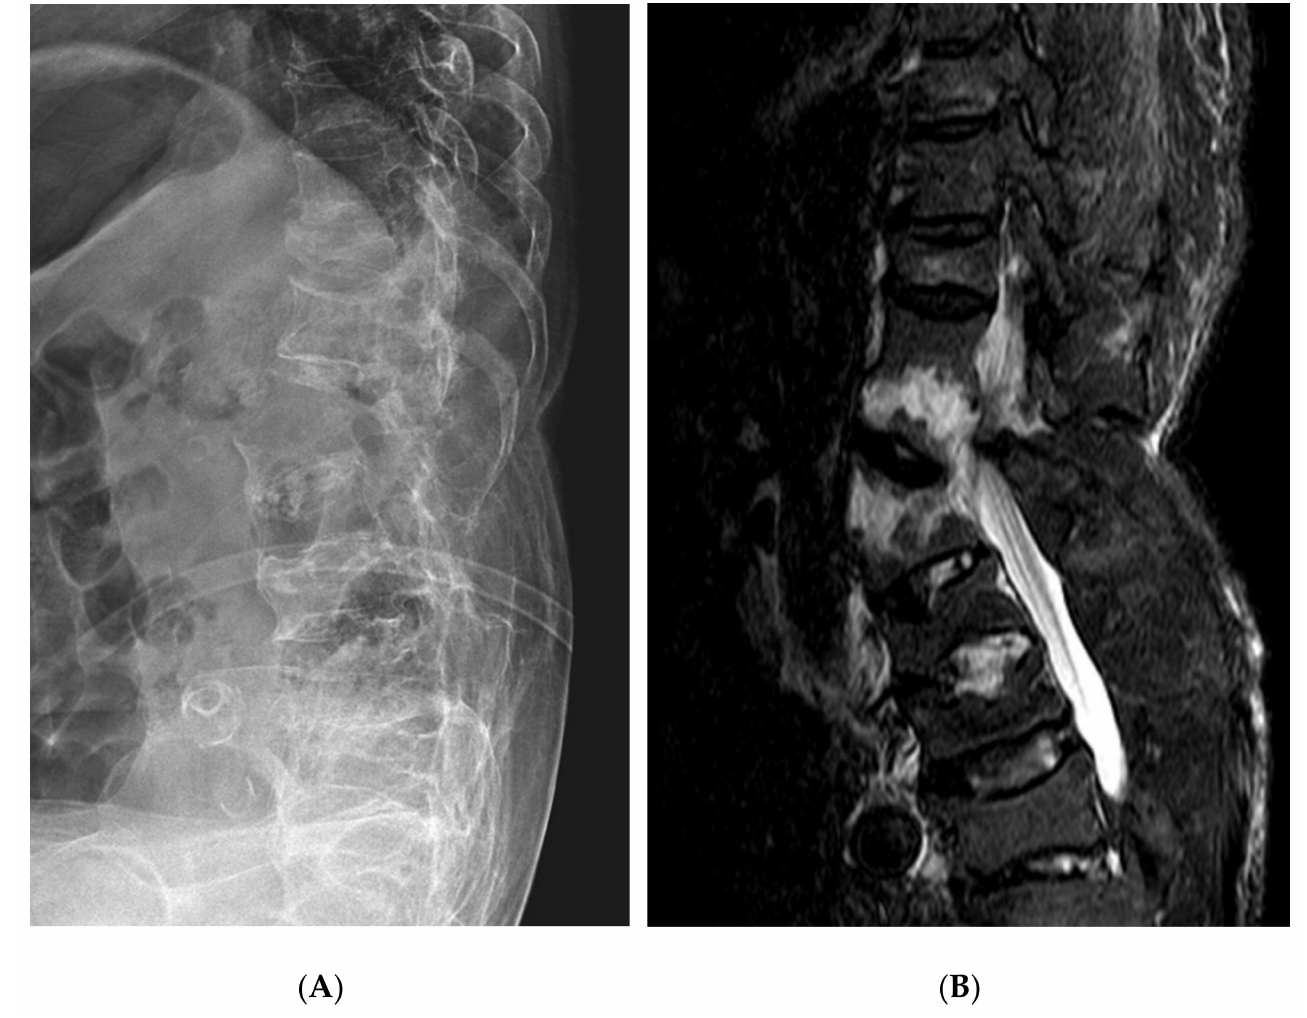
Figure 2. The lumbar spine lateral plain radiograph ( A ) and MRI sagittal view ( B ) after fracture. Emergency posterior fusion was planned for the thoracolumbar fractures with com- plete paraplegia. We expected that fracture reduction would not be easy because of AS. To reduce displacement of the fracture, after general anesthesia, we tried some fracture reduc- tion using abdominal support and operating table bending with the patient in the prone position before incision, but there was no change in the fracture site. Bone reduction was attempted again after incision and muscle dissection, but the fracture was not reduced at all. We performed in situ posterior fixation and fusion of T10–L3 vertebrae due to reduction failure and massive bleeding in the operative field (Figure 3). Upon imaging examination 10 months post operation, bone union was confirmed but neurological symptoms did not